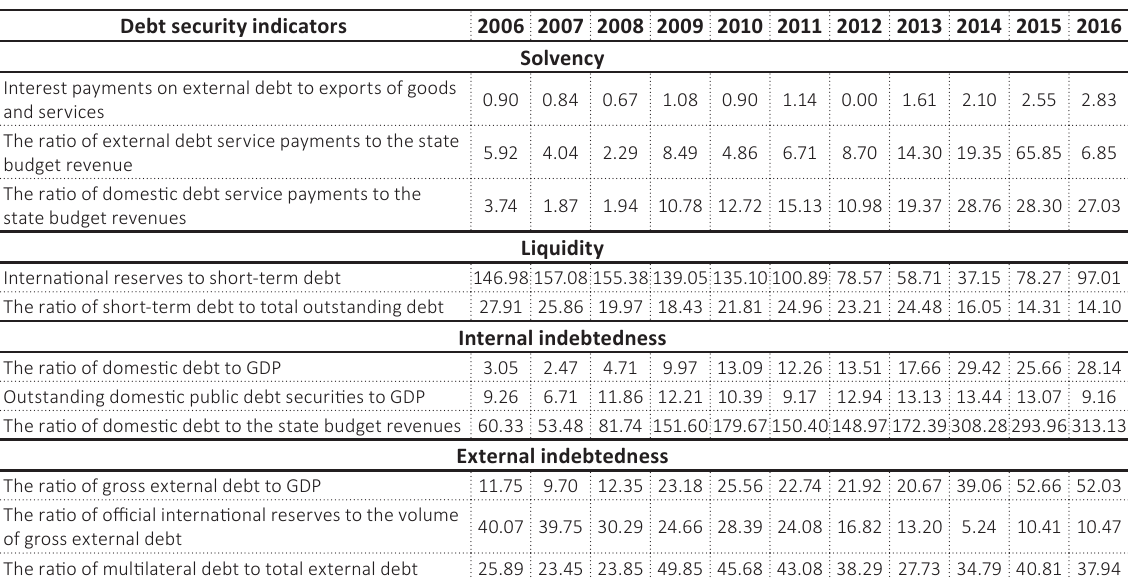
Source: Compiled by the